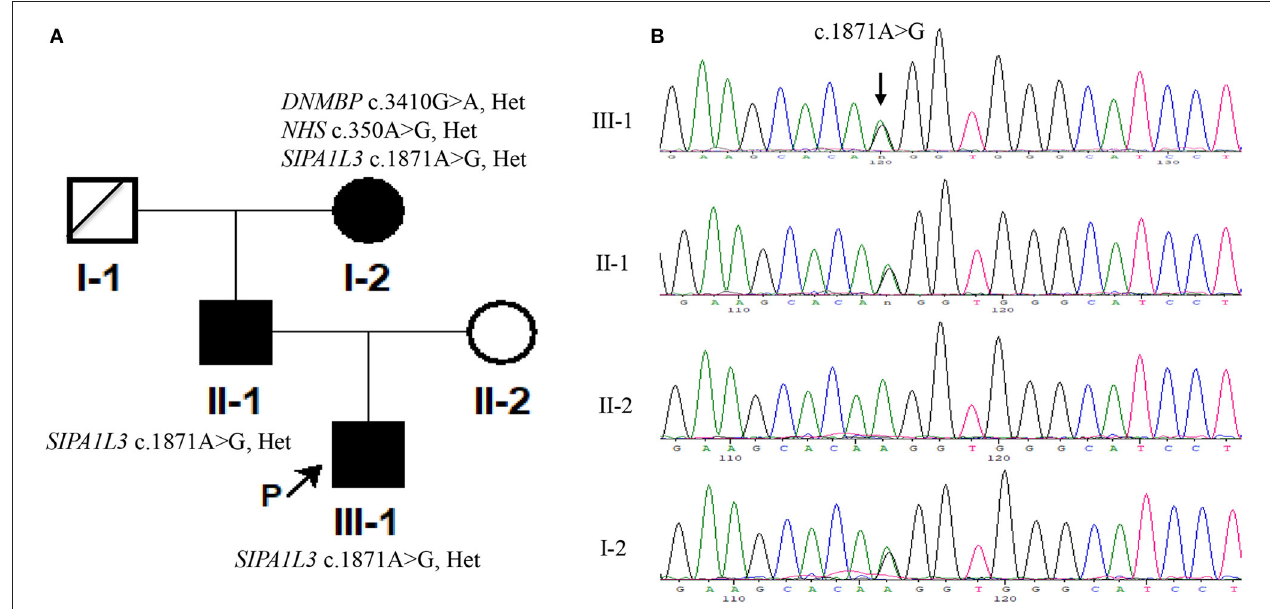
FIGURE 2 | The signal-induced proliferation-associated 1-like 3 ( SIPA1L3 ) c.1871A > G variation in the patients was detected by using Sanger sequencing. (A) The pedigree of the Chinese family in the current study. (B) Sanger sequencing results of c.1871A > G variation in the Chinese family. The genomic DNA used for PCR amplification was extracted using peripheral blood (III-1 and I-2) or oral swabs (II-1 and II-2). The sequencing was performed in both forward and reverse direction on a genetic analyzer 3730XL (Applied Biosystems). The results of forward sequencing are representatively